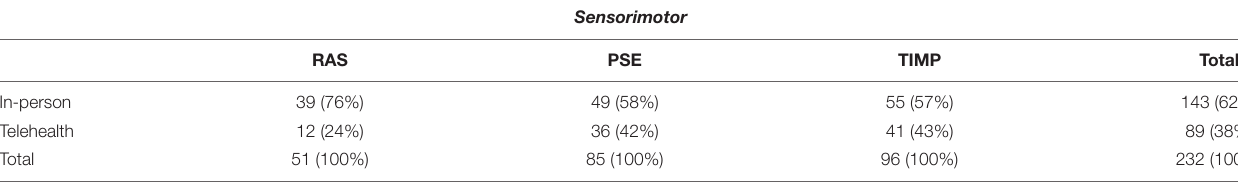
TABLE 2 | Breakdown of implementation of NMT by technique.